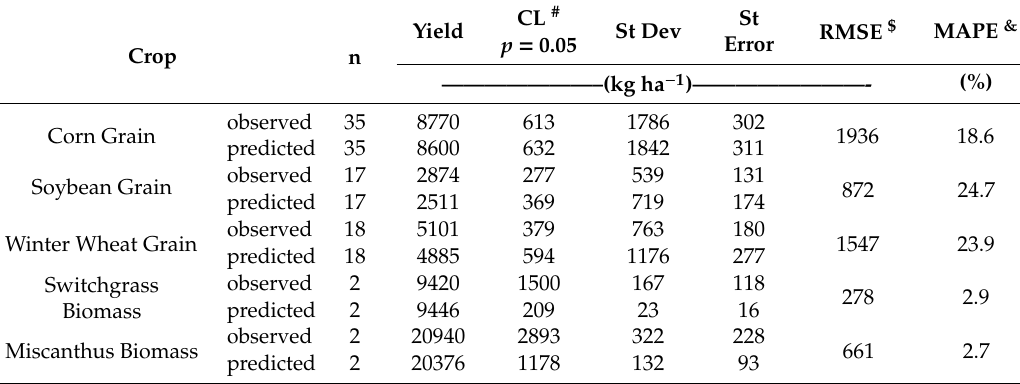
Figure 1. Predicted total annual precipitation (mm) and average annual temperature (°C) for two representative concentration pathways: RCP 4.5 and 8.5 during 1971–2100. Table 3. Observed and predicted crop yields and crop yield